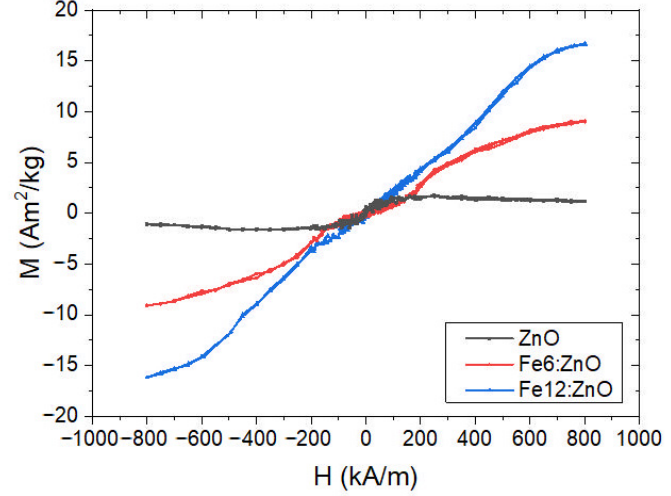
Figure 9. Magnetization–saturation (M-H) curves of ZnO and Fe:ZnO NPs with different doping levels, measured at room levels, measured at room temperature.